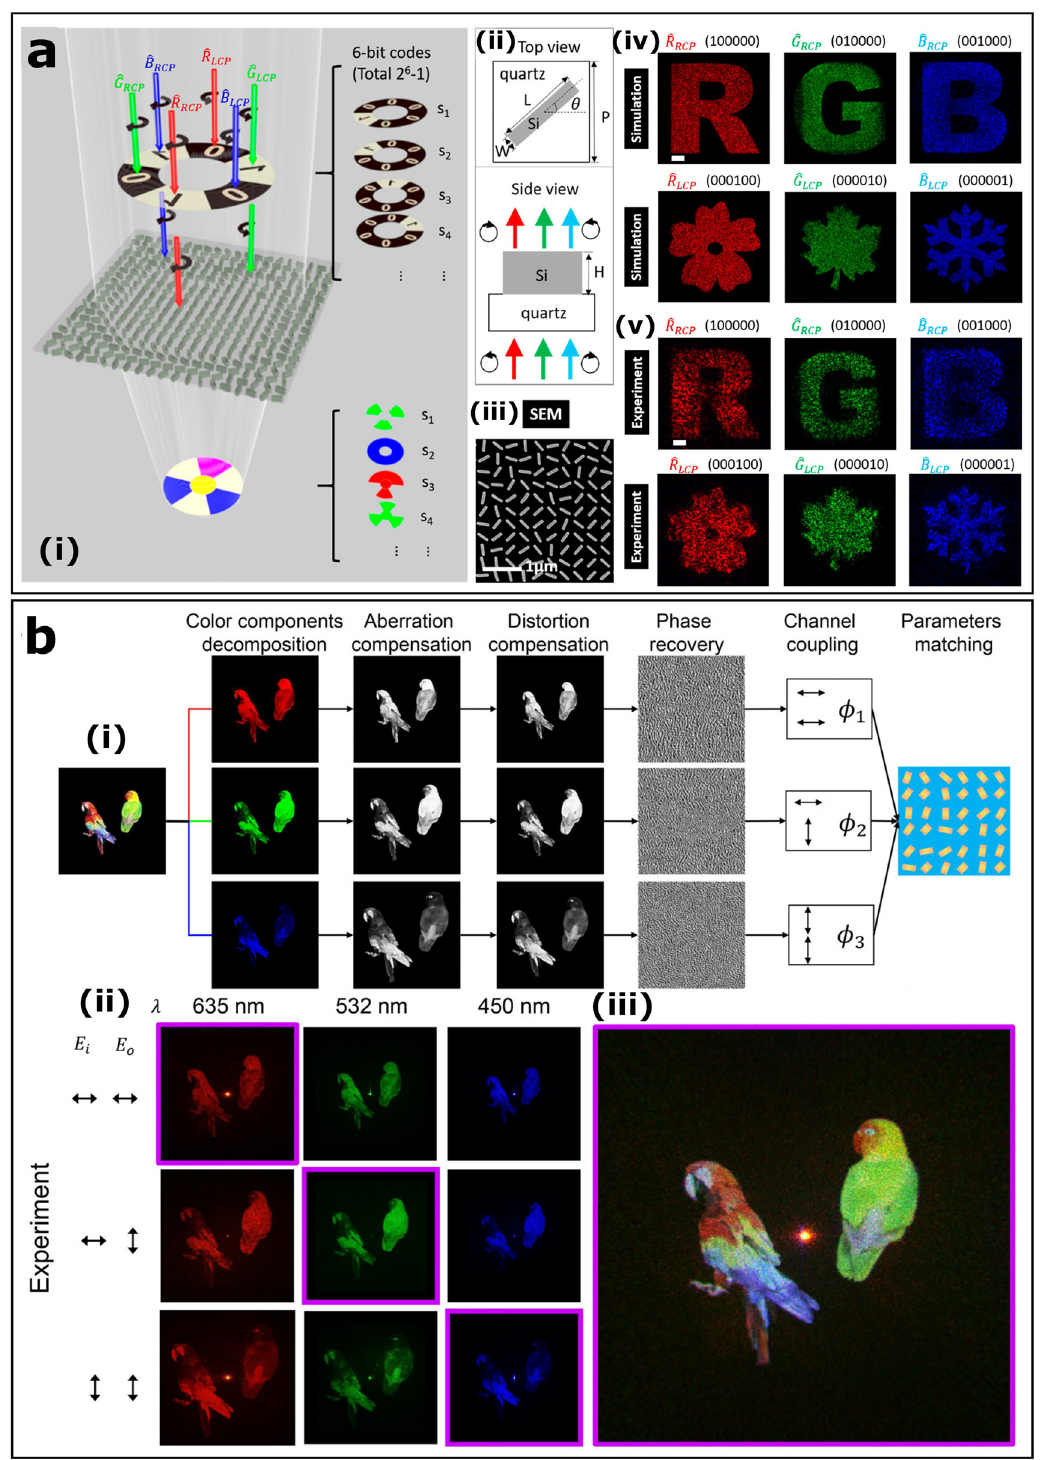
Figure 2: The non-interleaved metasurfaces. (a):(i)Schematicofthetransmission-type6-bitmetasurface.Thewavelengthswithspinsofinputbeamsrepresentthefundamentalbases.(ii) Geometry of the designed unit cell. (iii) SEM image of a partial region of the fabricated Si metasurface. Simulated (iv) and experimental (v) reconstruction of holograms from the designed multifunctional metasurface. Reproduced with permission from ref. [70]. Copyright 2018, American Chemical Society. (b): (i) Design process of vectorial color holographic metasurface. (ii) Experimental hologram images projected withallchannels.(iii)Thecomposedvectorialfull-colorhologramimage.Reproducedwithpermissionfromref.[71].Copyright2019,American Chemical